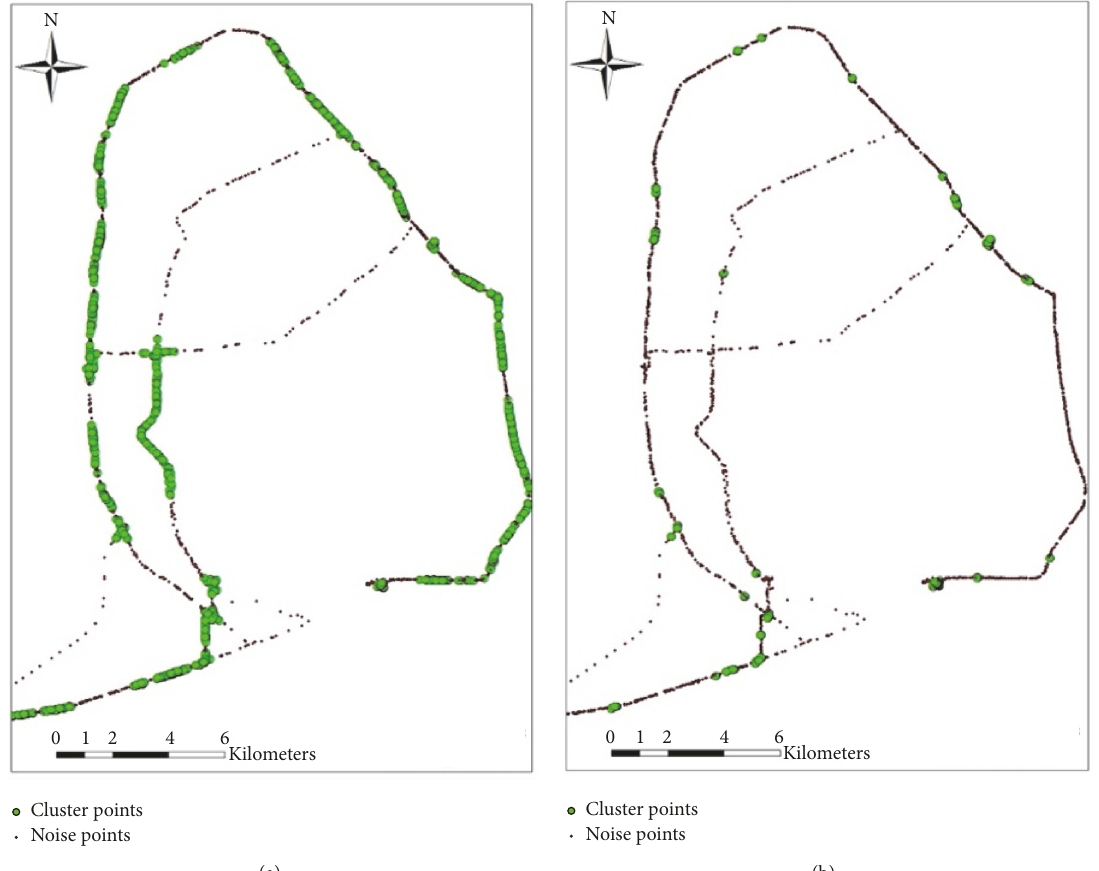
Figure 12: Clustering results of Sample Trajectory A by two algorithms: (a) HDBSCAN and (b) DBSCAN.